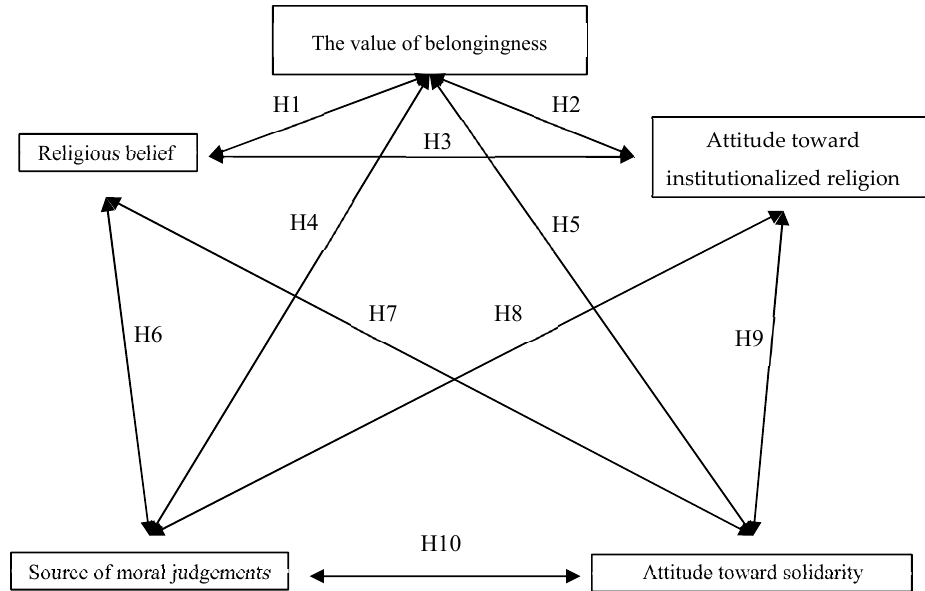
Figure 1. Research model and hypotheses.